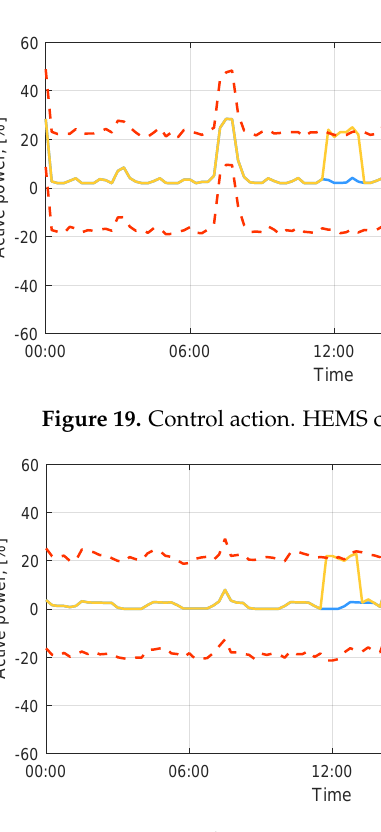
Figure 20. Control action. HEMS connected to node 115.